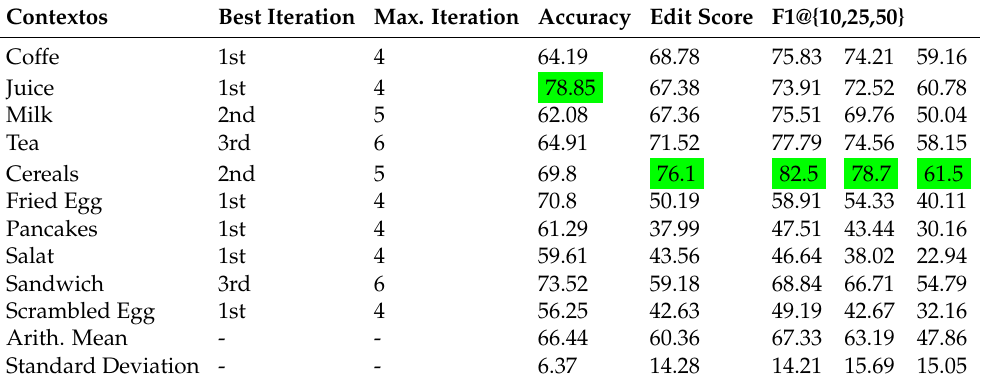
Table 15. RL-SSI in all breakfast contexts.